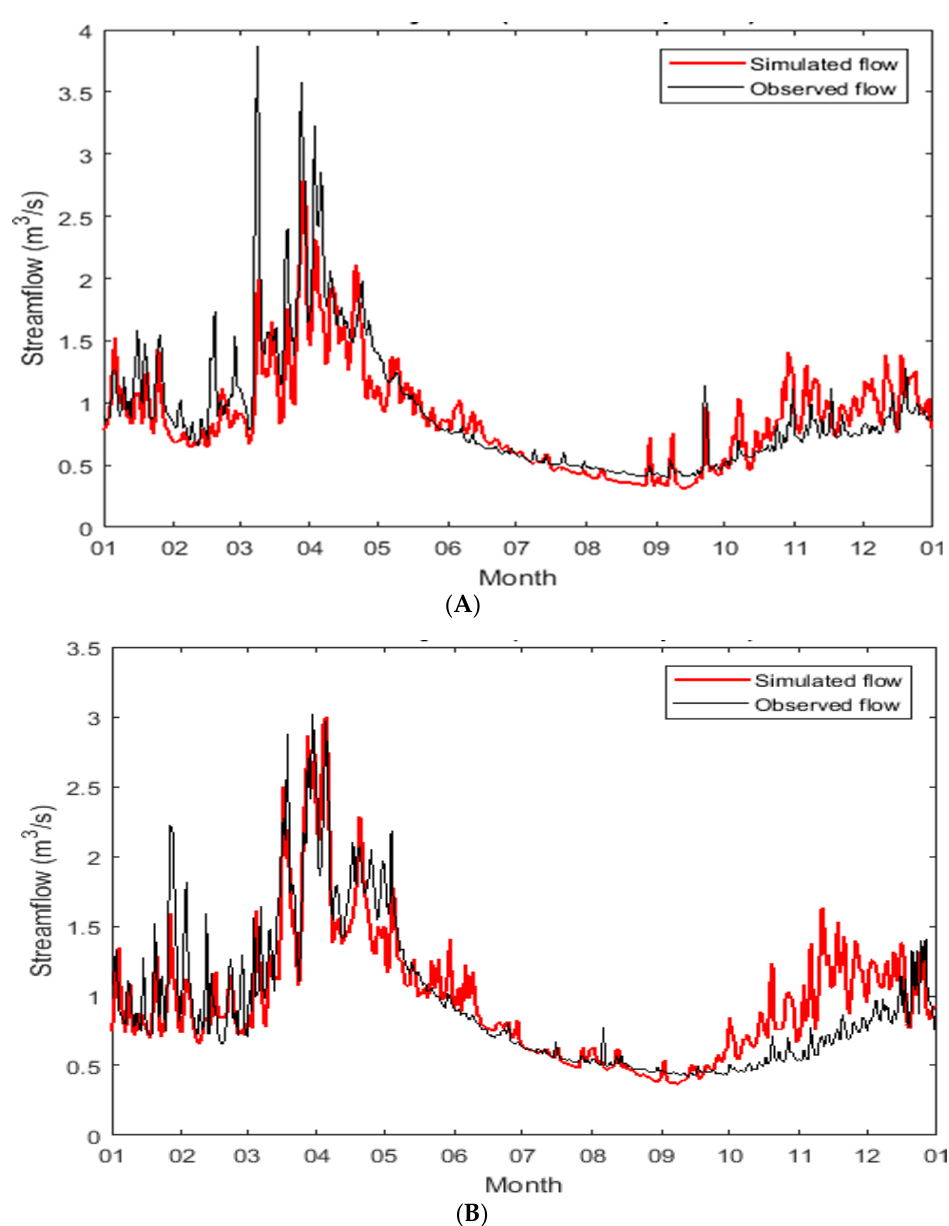
Figure 4. Daily interannual flow for the calibration period ( A ) and the validation period ( B ). A sub-sample of simulations and input data are shown in Figure 5. It can be observed that some peak flows are overestimated by the model for this period. However, low flows, which are the focus of the present work because of their impact on water availability, water quality and aquatic habitat, appear to be relatively adequately simulated (e.g., months of January, February, August and September).